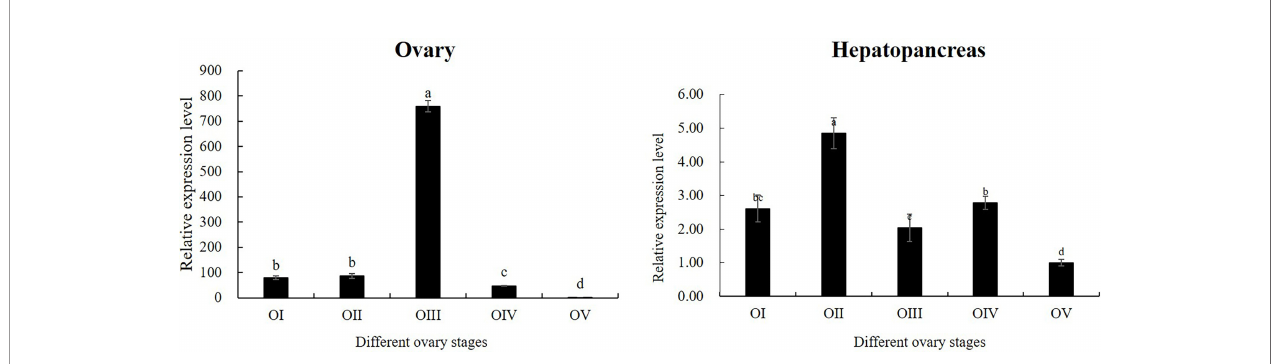
FIGURE 5 | Expression patterns of Mn-CL2 in the hepatopancreas and ovary at different ovarian stages. Different ovarian stages expressions, OI undeveloped stage, OII developing stage, OIII nearly-ripe stage, OIV ripe stage, OV spent stage. Statistical analyses were performed with one-way ANOVA analysis. Data are shown as mean ± SD (n = 5). Different letters denote signi fi cant differences (P < 0.05). Bars with different small letters indicated signi fi cant differences (P < 0.05).